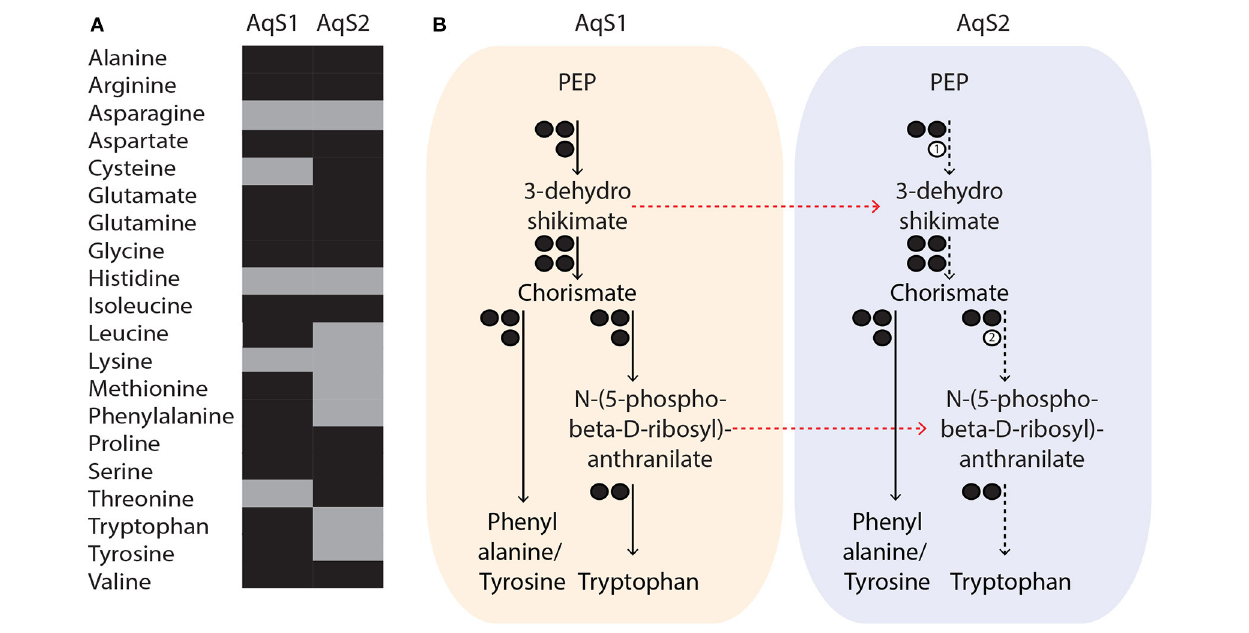
FIGURE 5 | (A) Putative metabolic capacity of amino acid biosynthesis in AqS1 and AqS2 . Amino acids are represented in different colors, depending on whether their biosynthesis pathway was predicted to be complete (black) or partially complete (gray) by the RAST server. (B) Example of possible metabolic complementation occurring between AqS1 and AqS2 . AqS2 could rely on the metabolism of AqS1 to supply intermediate substrates that are required for the synthesis of aromatic amino acids. The number of genes involved in each pathway is shown as circles. Presence or absence of enzymes is indicated by black or white circles, respectively. (1) 3-dehydroshikimate and (2) N-(5-phospho-beta-D-ribosyl)-anthranilate. All paths that are partial are represented by dashed instead of solid arrows and red arrows indicate the possible movement of intermediary metabolites between the two symbionts. PEP: